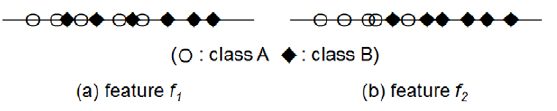
Figure 1. Clearness of feature f 1and f 2. Mixed area of f 1 is larger than f 2, and it means feature f 2 is clearer than f 1 .